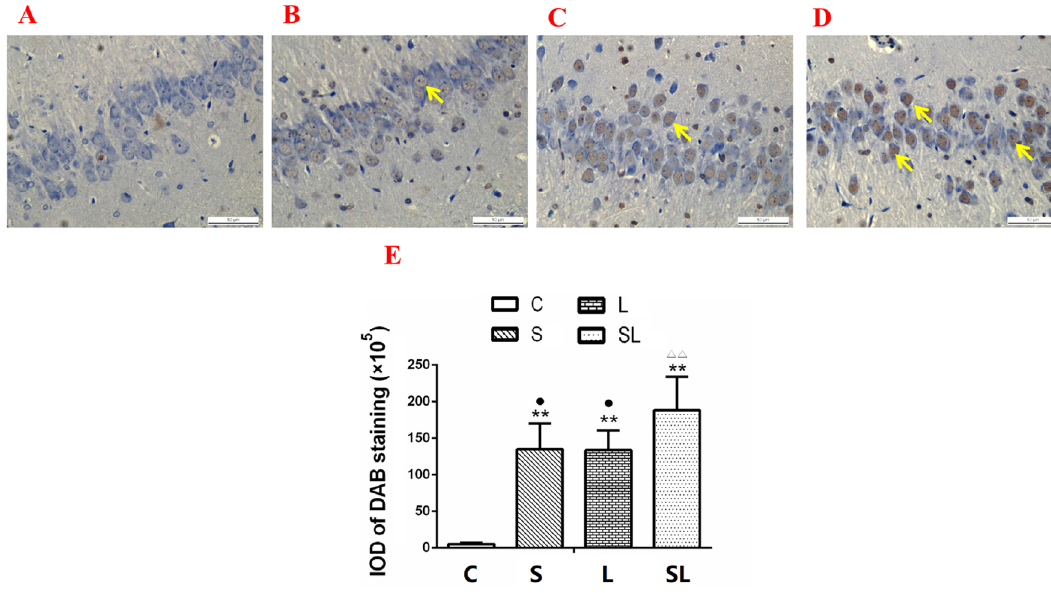
Figure 4. Cell apoptosis in the hippocampus of rats 6 h after 2.856 GHz and 1.5 GHz microwave exposures, as detected by TUNEL staining. ( A – D ) Hippocampi of the C group, S group, L group and SL group (TUNEL, scale bar = 50 μm). (E) IOD changes in the hippocampus. Compared to the C group, ** p < 0.01. Compared to the cumulative group, • p < 0.05. ΔΔ p < 0.01 indicates the existence of interaction effects between the 2.856 GHz and 1.5 GHz microwaves. “C” stands for the control group, “S” stands for the 2.856 GHz microwave exposure group, “L” stands for the 1.5 GHz microwave exposure group, and “SL” stands for the 2.856 and 1.5 GHz cumulative exposure group. The data are presented as the means ±